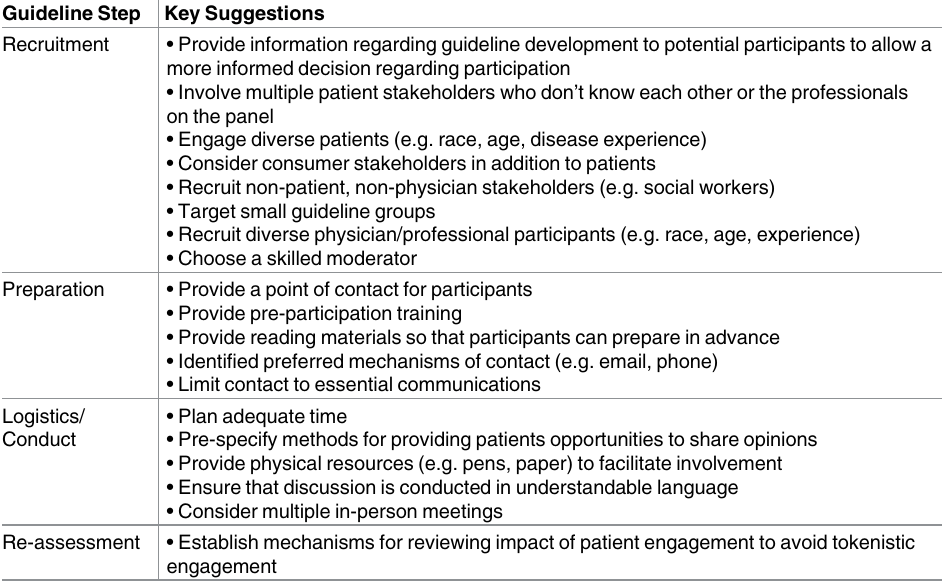
Table 3. Key Suggestions for Guideline Developers. Guideline Step Key